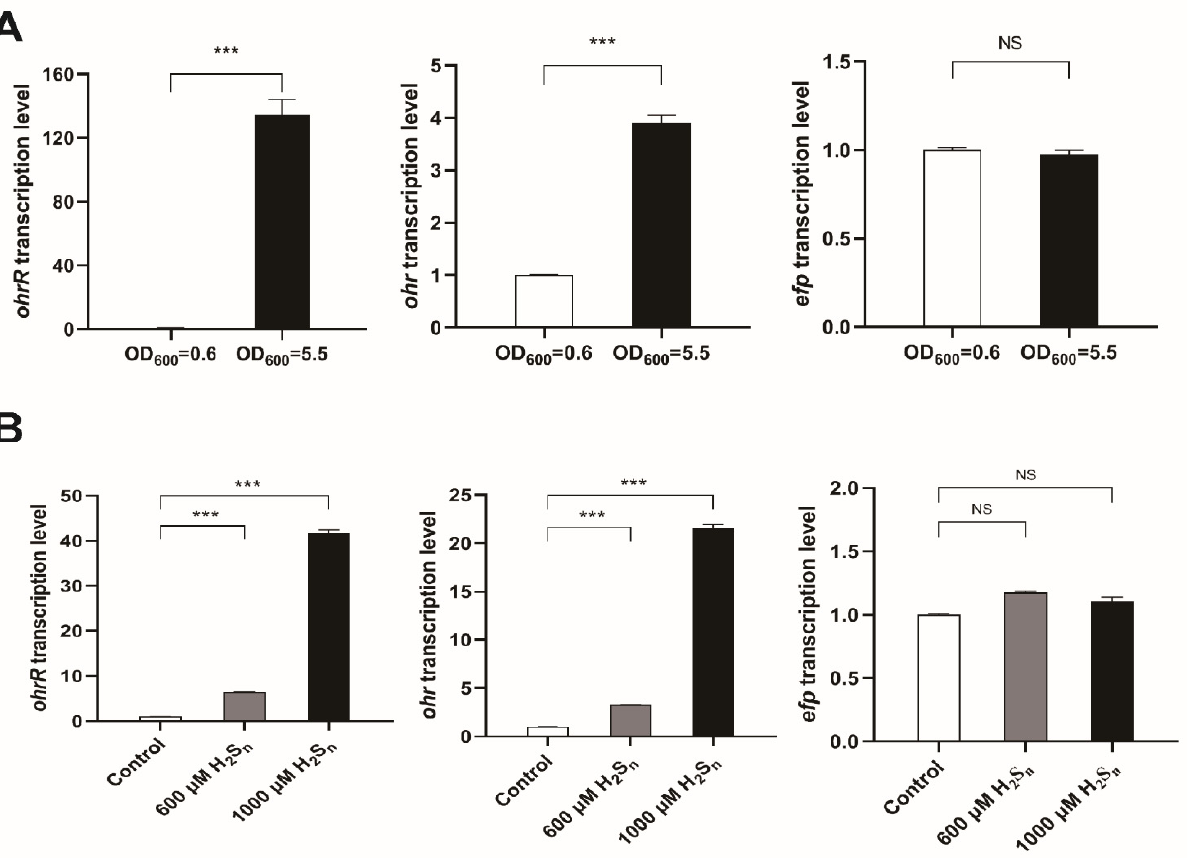
Figure 5. The ohrR and ohr expression were associated with sulfane sulfur levels in P. aeruginosa PAO1 . ( A ) RT-qPCR was used to quantify the expression of ohrR , ohr , and efp in PAO1. PAO1 cells were sampled at OD 600nm of 0.6 or 5.5 for RNA extraction. ( B ) H 2 S n induced the expression of ohrR and ohr . The transcripts of ohrR and ohr were analyzed by RT-qPCR. Cells grew in LB medium until OD 600nm of 2 before adding H 2 S n for 20-min induction. The induced and uninduced cells were collected, and RNA was extracted. The rplS transcript was used as the internal standard. Unpaired t tests were performed (*** p < 0.001). NS = ( p > 0.05). The values are averages of three measures with standard deviations (error bars).